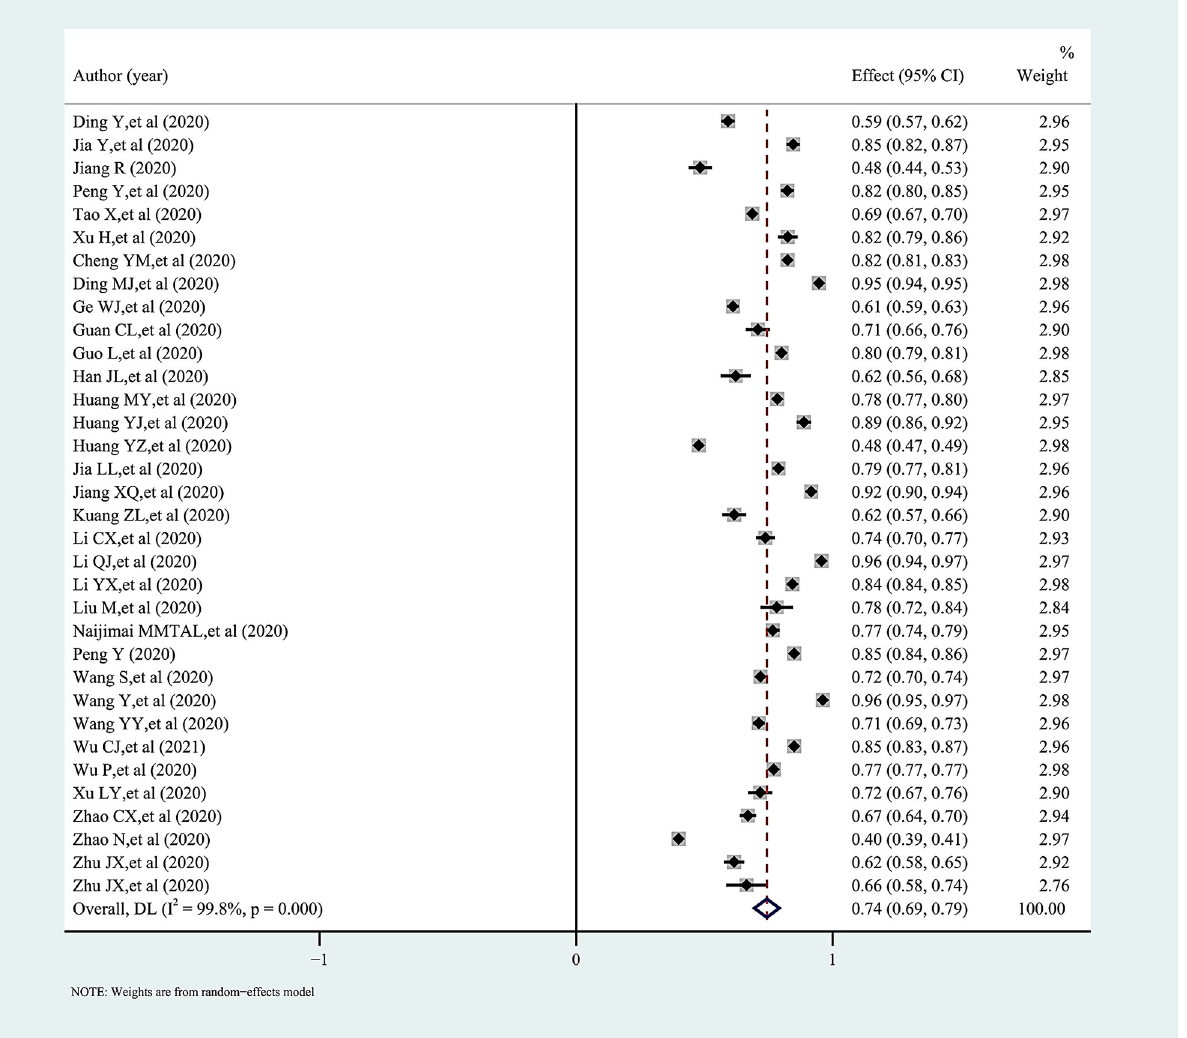
Fig 2. Forest plot showing the overall proportion of knowledge about COVID-19 among study subjects.